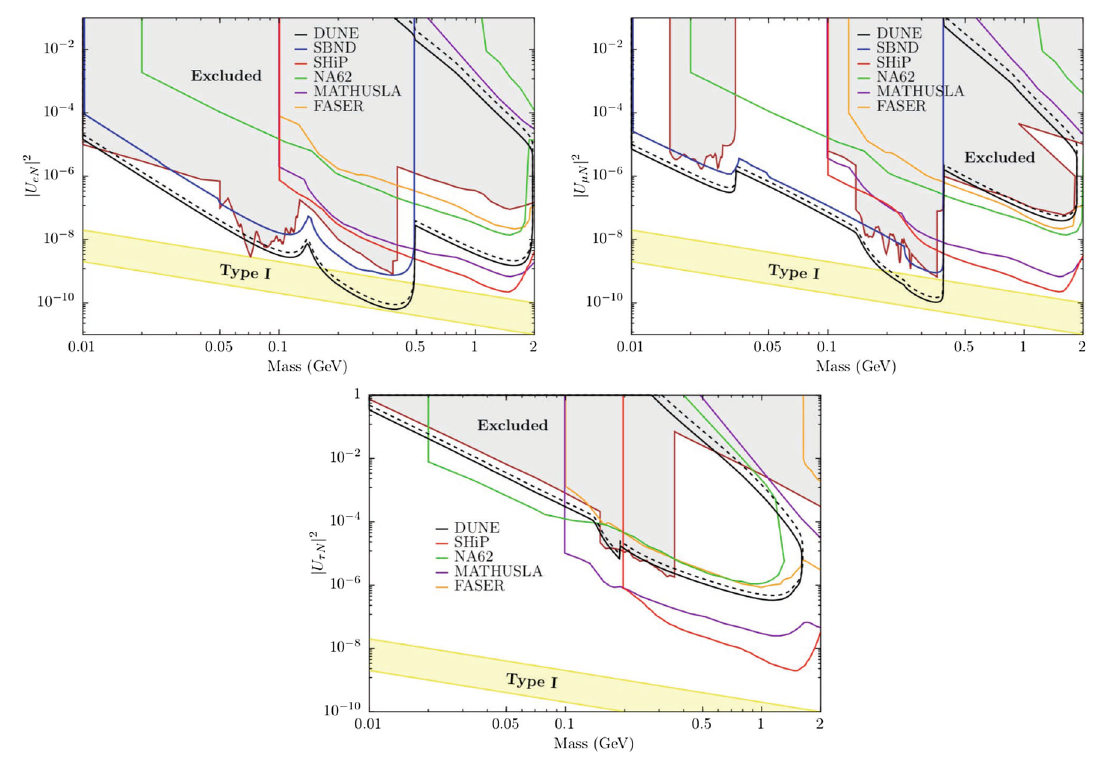
Fig. 40 The 90% CL sensitivity regions for dominant mixings | U eN | 2 (top left), | U μ N | 2 (top right), and | U τ N | 2 (bottom) are presented for DUNE ND (black) [287]. The regions are a combination of the sen- sitivity to HNL decay channels with good detection prospects.These are N → ν ee , ν e μ , νμμ , νπ 0 , e π , and μπ . The study is per- formed for Majorana neutrinos (solid) and Dirac neutrinos (dashed), assuming no background. The region excluded by experimental con- straints (grey/brown) is obtained by combining the results from PS191 [288,289], peak searches [290–294], CHARM [295], NuTeV [296],